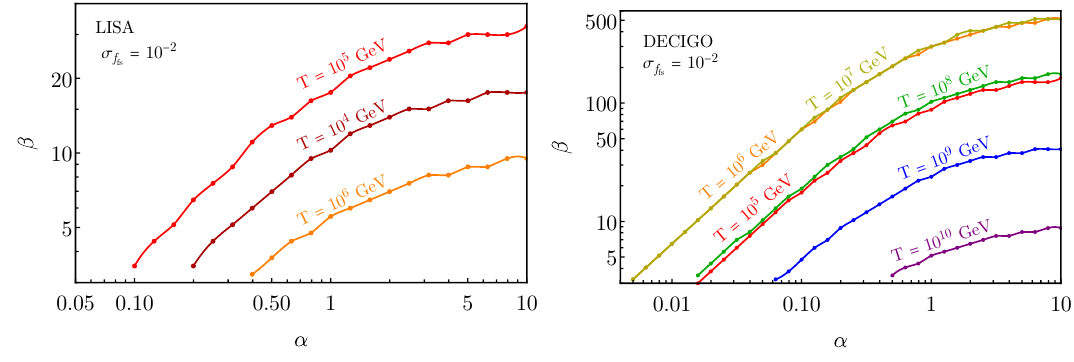
Figure 5 . The regions of phase transition parameter space for which the well motivated value of f FS ∼ 10 − 2 can be reached at LISA (left) and DECIGO (right). For a given value of T PT , as long as the phase transition parameters α and β are to the right of the line, then a sensitivity of f FS ∼ 10 − 2 can be